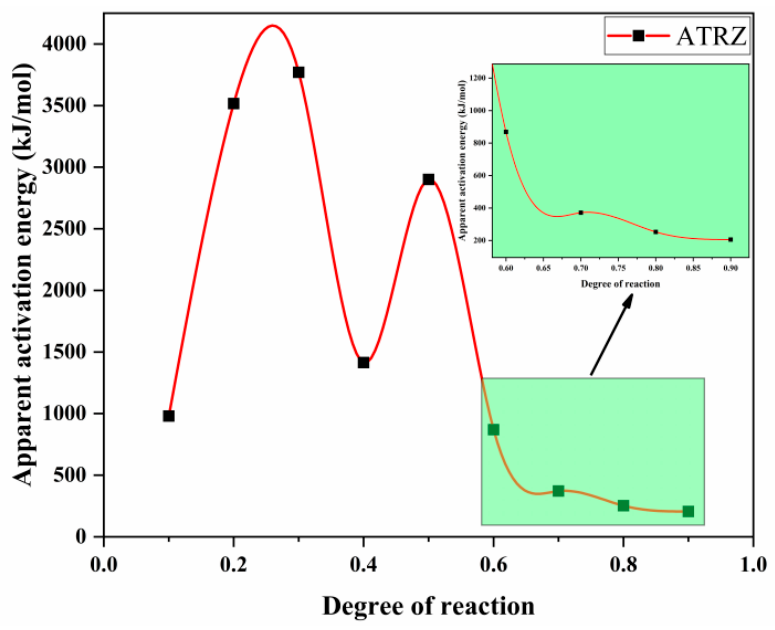
Figure 8. E O analysis diagram of ATRZ created by the Ozawa method.